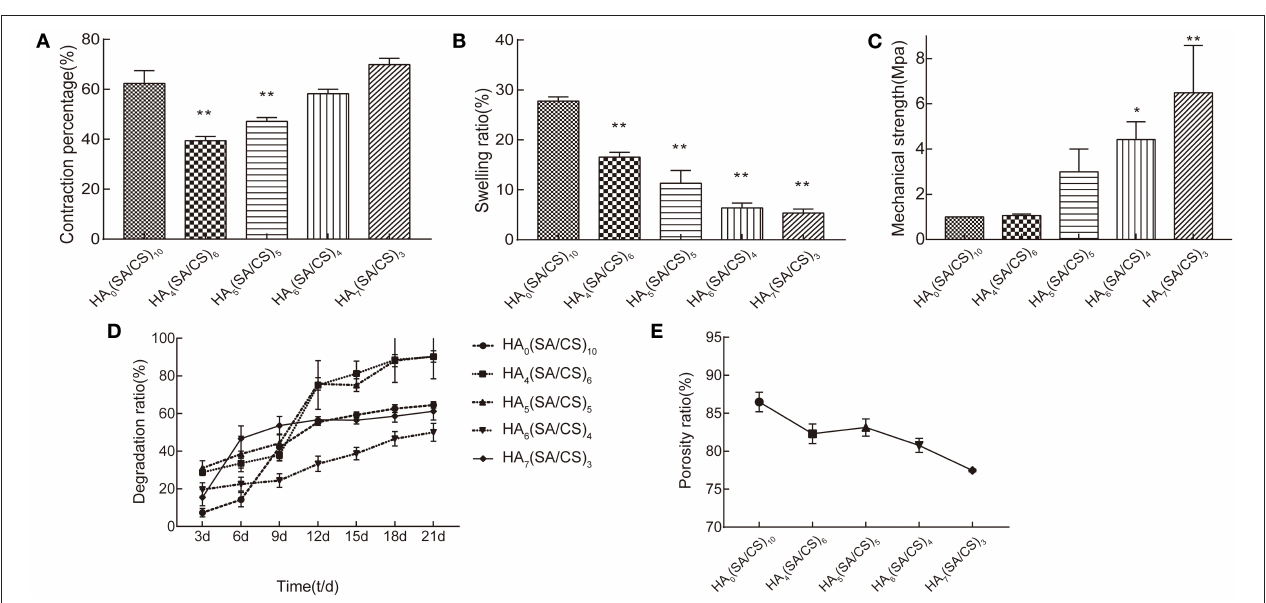
FIGURE 4 | (A) Contraction percentage, (B) swelling ratio, (C) mechanical strength, (D) degradation ratio, (E) porosity ratio of HA 0 (SA/CS) 10 scaffold, HA 4 (SA/CS) 6 scaffold, HA 5 (SA/CS) 5 scaffold, HA 6 (SA/CS) 4 scaffold, and HA 7 (SA/CS) 3 scaffold. * p < 0.05, ** p < 0.01.